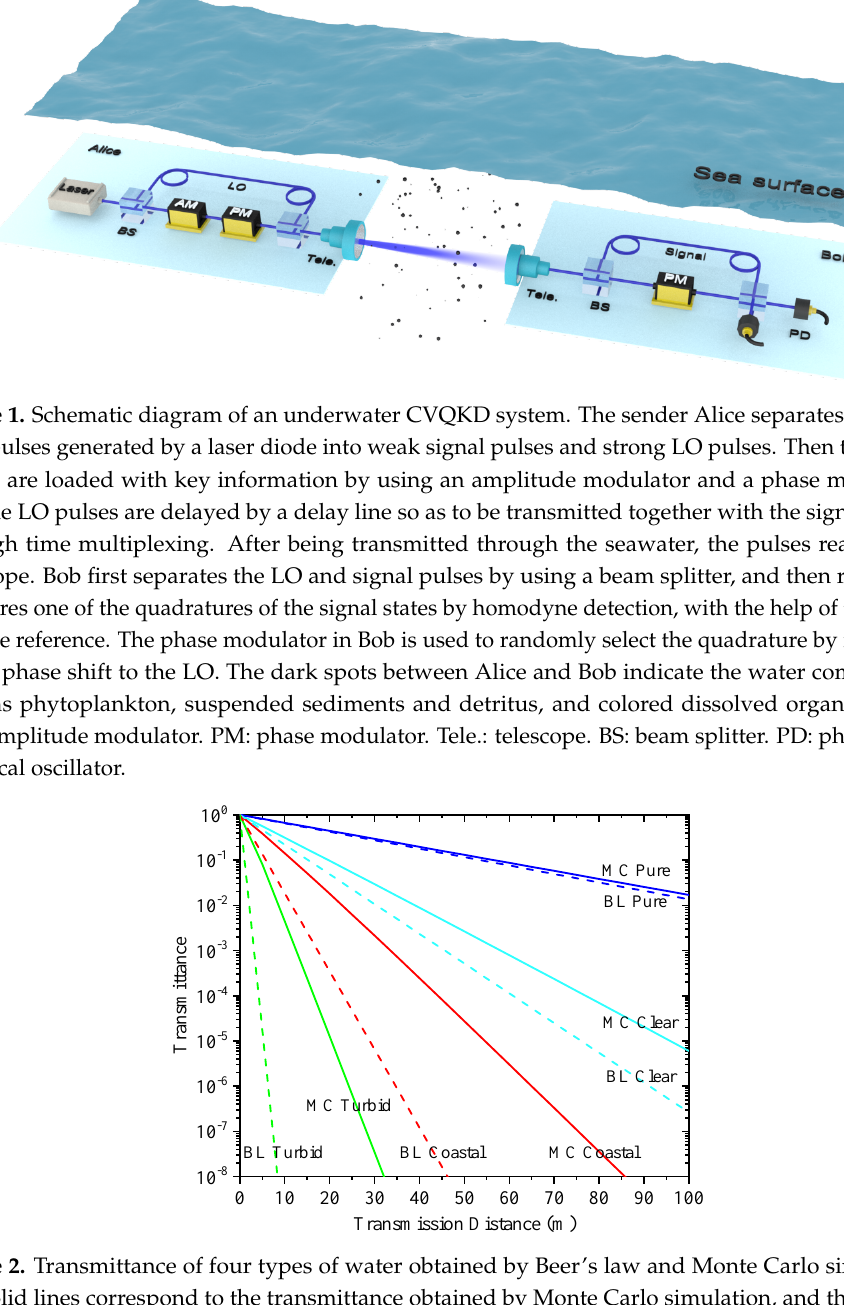
Figure 2. Transmittance of four types of water obtained by Beer’s law and Monte Carlo simulation. The solid lines correspond to the transmittance obtained by Monte Carlo simulation, and the dashed lines correspond to the transmittance obtained by Beer’s law. From left to right, the lines correspond, respectively, to turbid harbor water, coastal ocean water, clear ocean water, and pure sea water case. MC: results obtained by Monte Carlo simulation. BL: results calculated by Beer’s